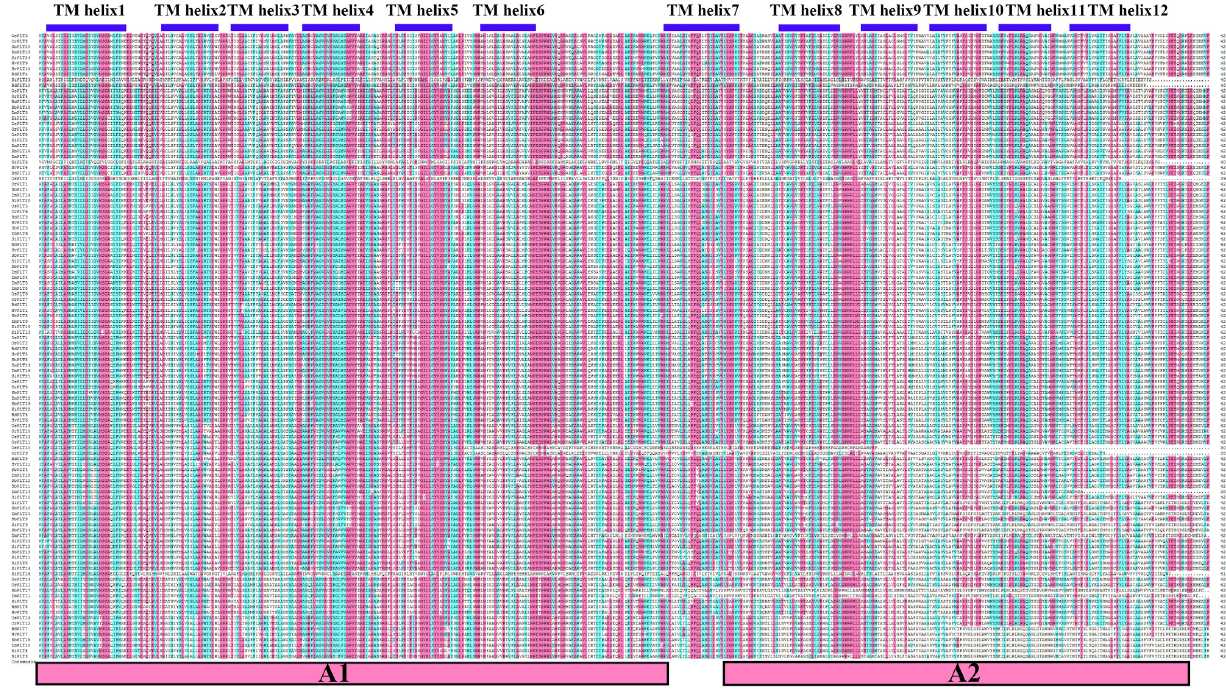
Frontiers in Genetics |